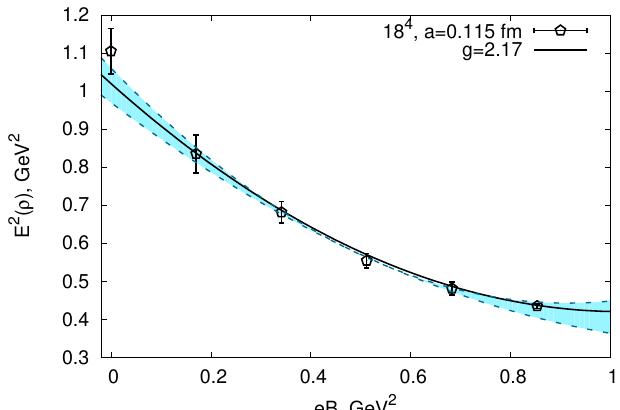
Figure 8. The energy squared of the ground state of the (cid:26) + ( (cid:26) (cid:0) ) meson with the spin projection s z = +1 ( s z = (cid:0) 1) versus the (cid:12)eld value for the lattice spacing a = 0 : 115 fm, the lattice volume 18 4 and the pion mass 395(6) MeV. The curve is the (cid:12)t to the lattice data performed of formula (4.1). The shaded area represents the error of E 2 at the (cid:12)xed g -factor value.